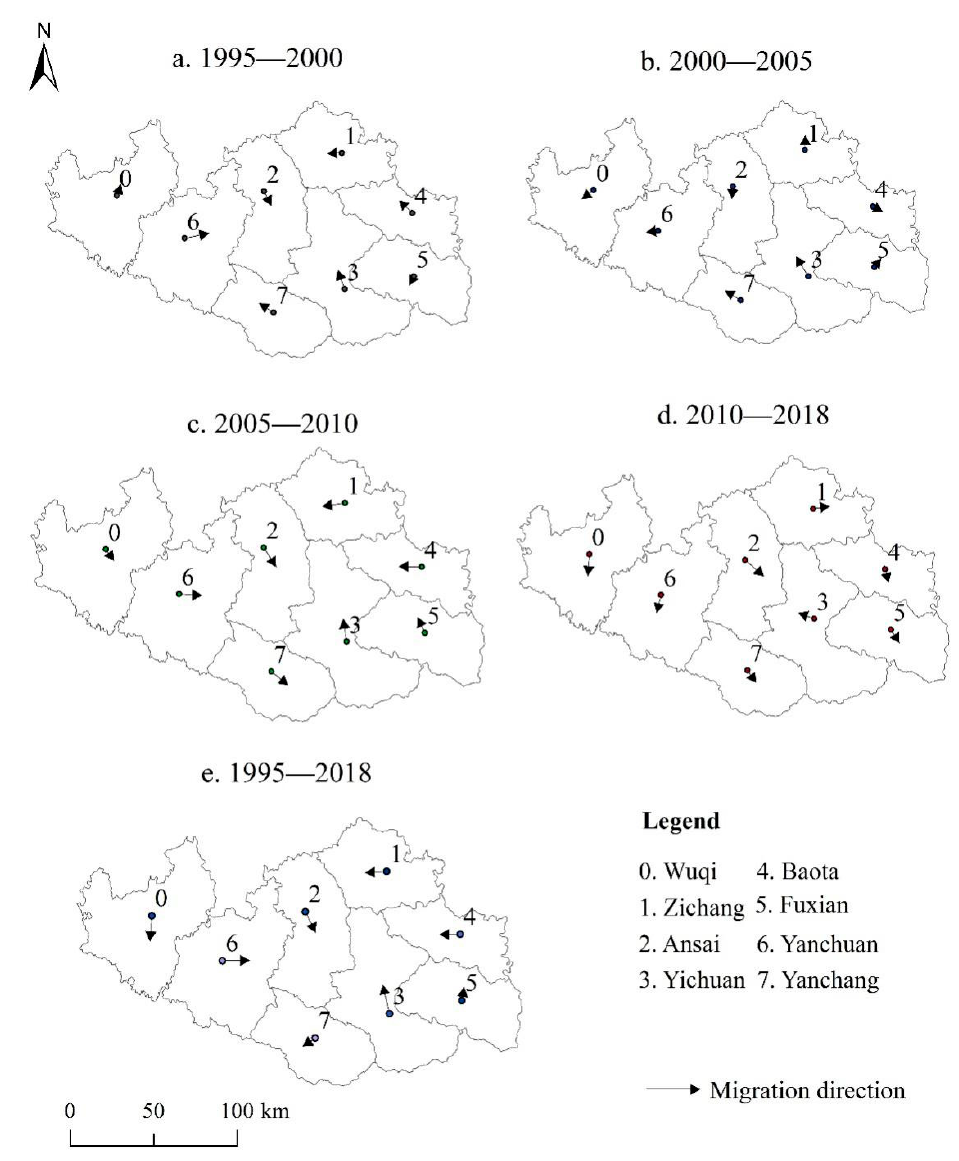
Figure 5. The center of gravity coordinate migration of gully farmland in districts of Yan’an City. The spatial distribution characteristics of different types of gully farmland are shown in Figure 6. The growth of the gully farmland is mainly distributed in the relatively gentle low-altitude flat dam area, including elevation (700–1300 m), terrain relief (40–180 m), and slope (0–20 ◦ ). The growth of oilseeds (IV), mulberry leaves (V), and tobacco leaves (VI) were negatively correlated with the distance between rivers, county roads, and provincial roads, and the increase was mainly within 5 km from rivers and 18 km from provincial roads. In general, the influence of the regional centers of townships on the cultivation of gully farmland was more significant than that of the regional centers of districts and counties. There was a strong market location orientation between economic fruit forest (I) and greenhouse vegetables (II), which was more manifested as agglomeration within the township, showing a “bottom-up” market location-oriented